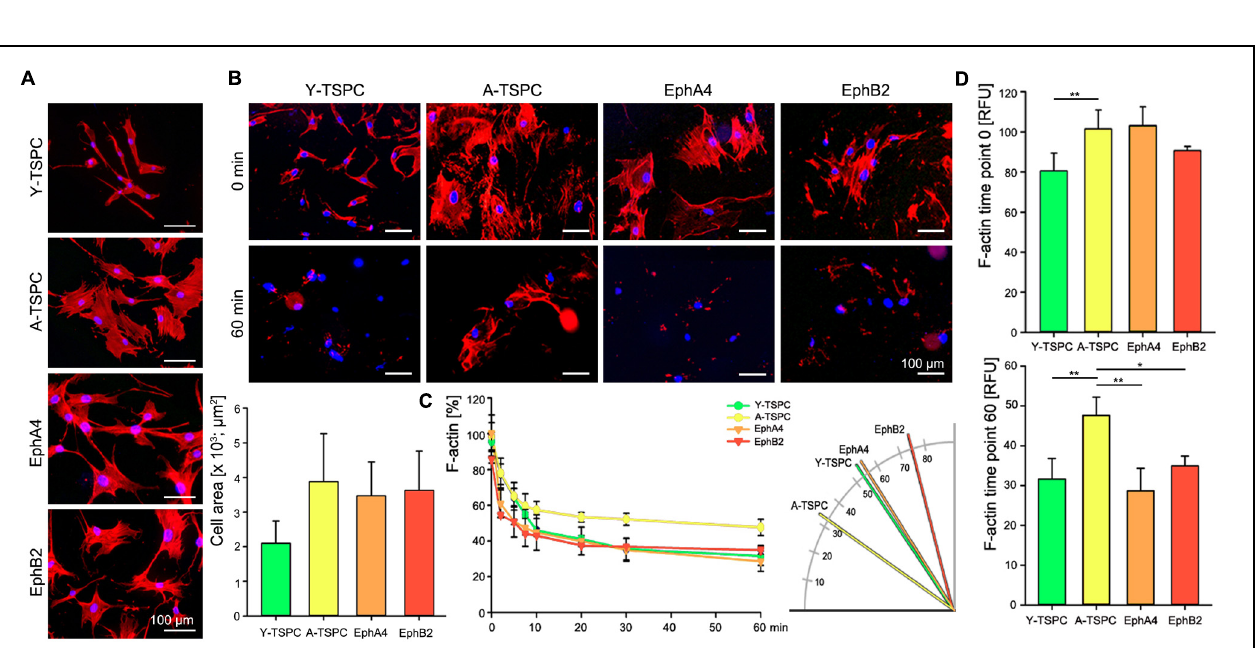
FIGURE 5 | Actin dynamics of EphA4-Fc and EphB2-Fc A-TSPC. (A) Representative images of F-actin staining and quantification of the cell area of Y-TSPC, EphA4-Fc, EphB2-Fc, and control-Fc A-TSPC ( n = 9, total of 50 cells per donor). (B) Representative images of Y-TSPC, EphA4-Fc, EphB2-Fc, and control-Fc A-TSPC at seven time points during latrunculin A treatment. (C) Quantification of actin filament dynamics in a time-dependent manner and curve declination angle. (D) Total actin content at the beginning (0 min) and at the end (60 min) of the latrunculin A experiment ( n = 9, ∗ p < 0.05; ∗∗ p < 0.01).